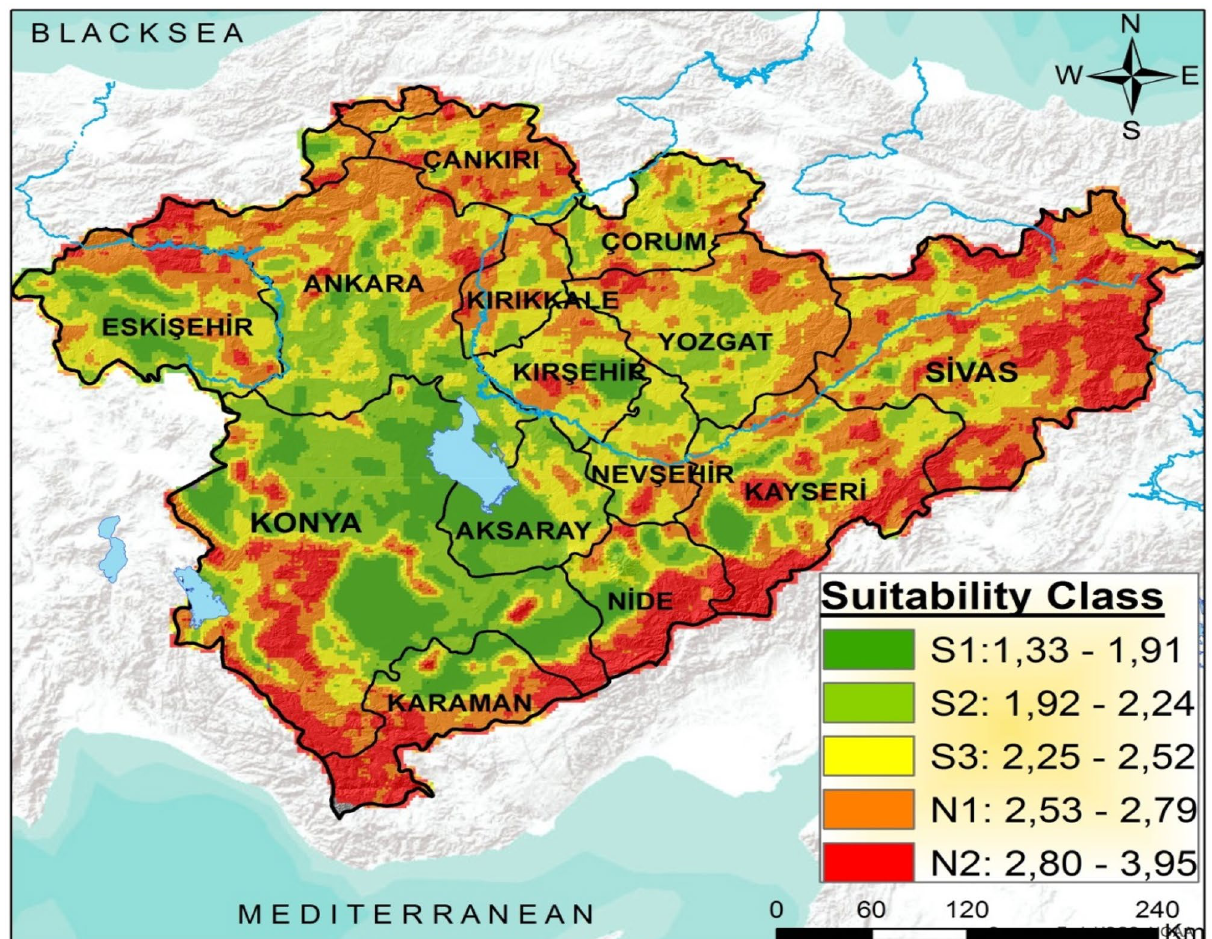
Figure 5. Land suitability classes for agriculture usages of the Central Anatolia Region (the map was created by the authors using the ArcGIS 10.2,